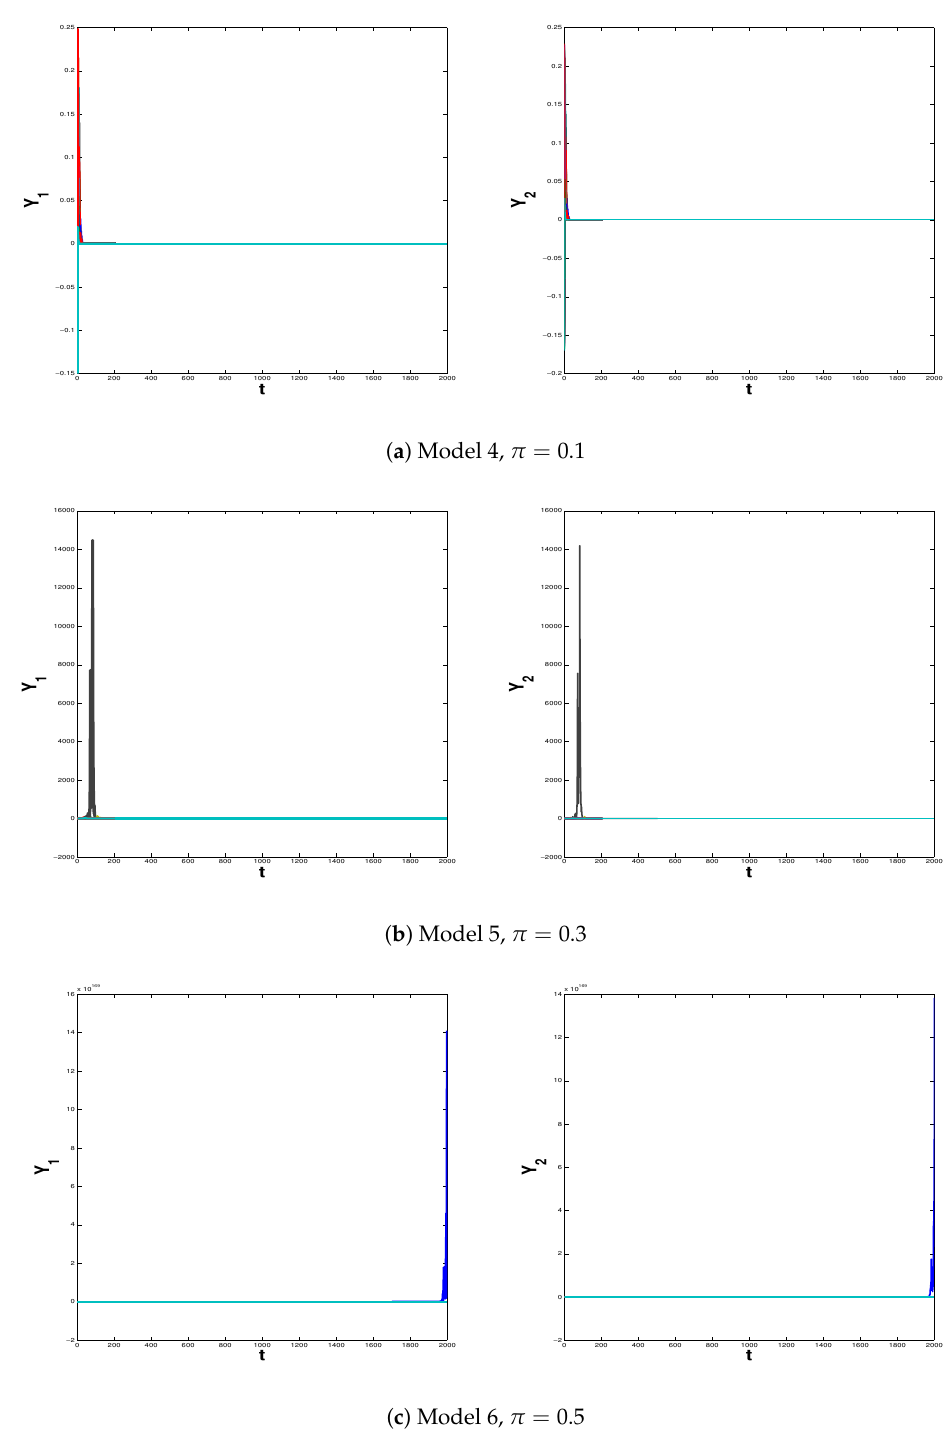
Figure A2. Simulated paths represented by different colors from models 4–6 for a different set of histories over a n = 2000 period using m = 200 simulated paths. The parameters are those from Table 1 and the probability to be in the explosive regime 2 is equal to π